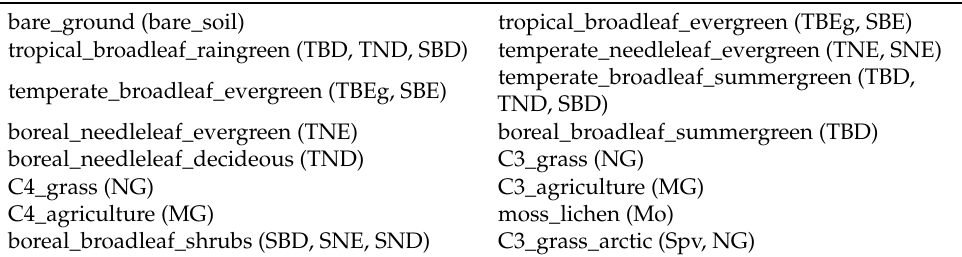
Table A3. Biome PFTs and related generic PFTs